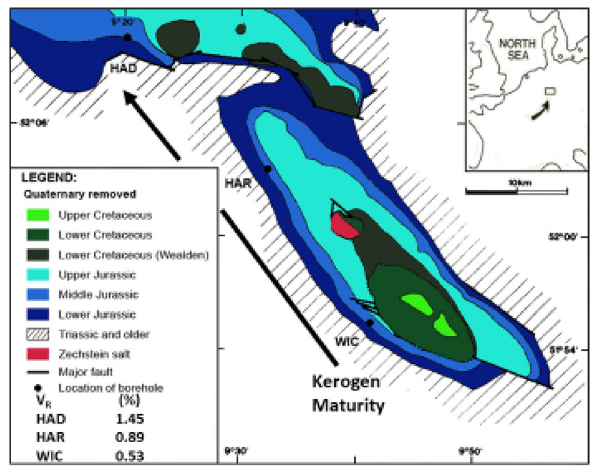
Fig. 1 Posidonia shale samples used in this study (modified from